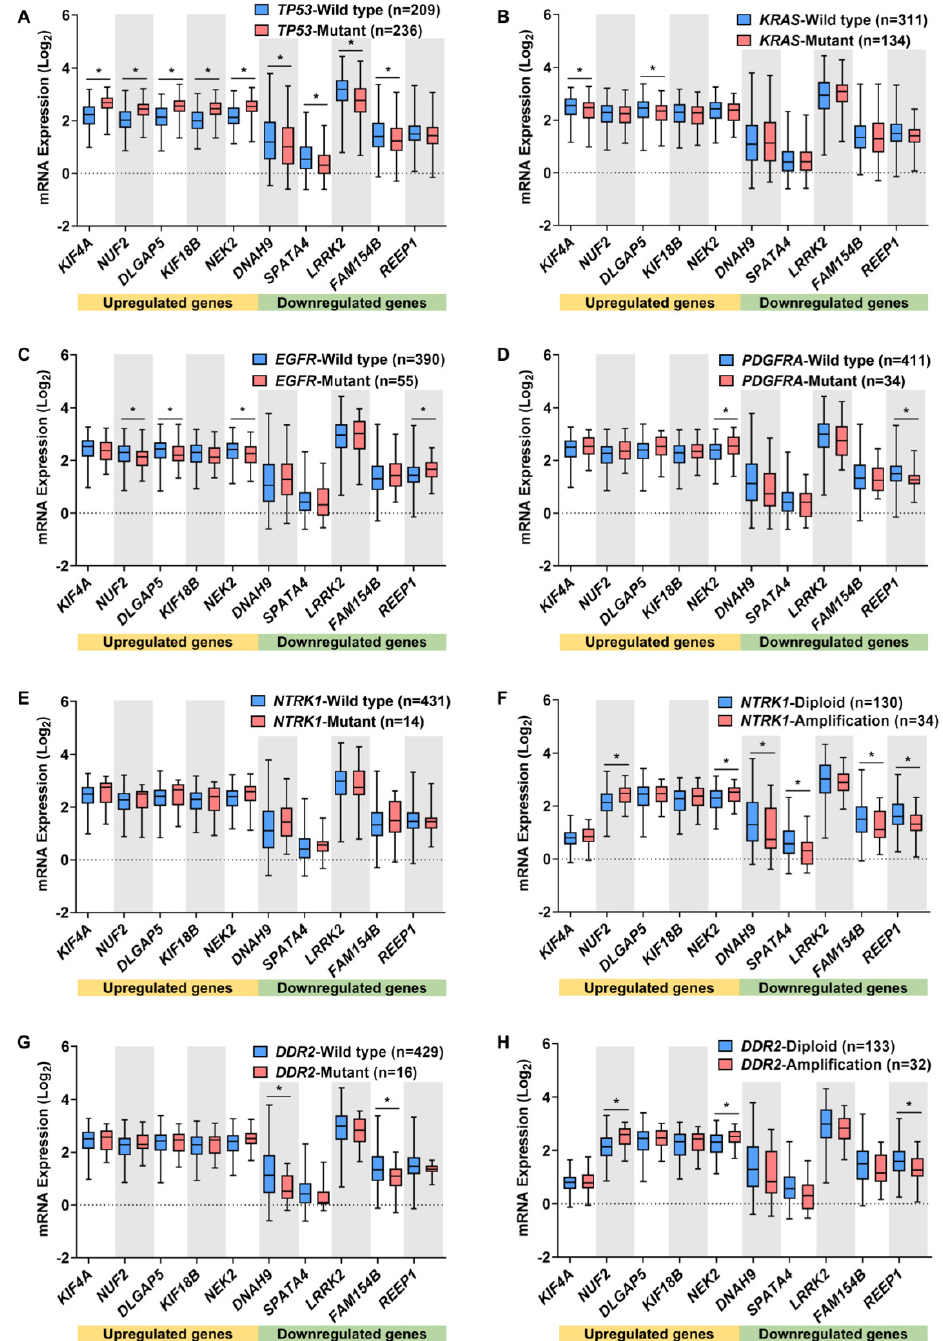
Figure 3. Relationships between the top five DEMG expressions in LUAD and its lung cancer hallmark gene alterations. Box plots demonstrate the association between DEMG expressions and mutation of TP53 ( A ), KRAS ( B ), EGFR ( C ), PDGFRA ( D ), NTRK1 ( E ), and DDR2 ( G ), and amplification of NTRK1 ( F ), and DDR2 ( H ). * p < 0.05 vs. wild-type or diploid group.